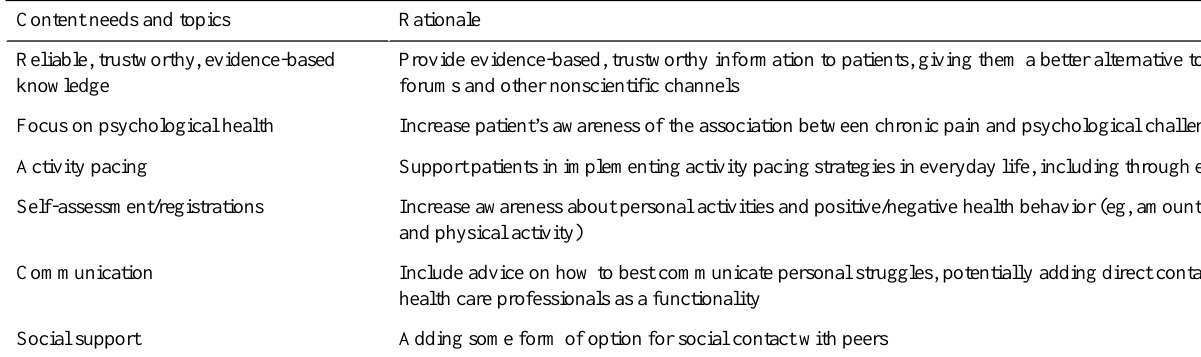
Table 4. Results from workshops with collaborating partners (N=14).